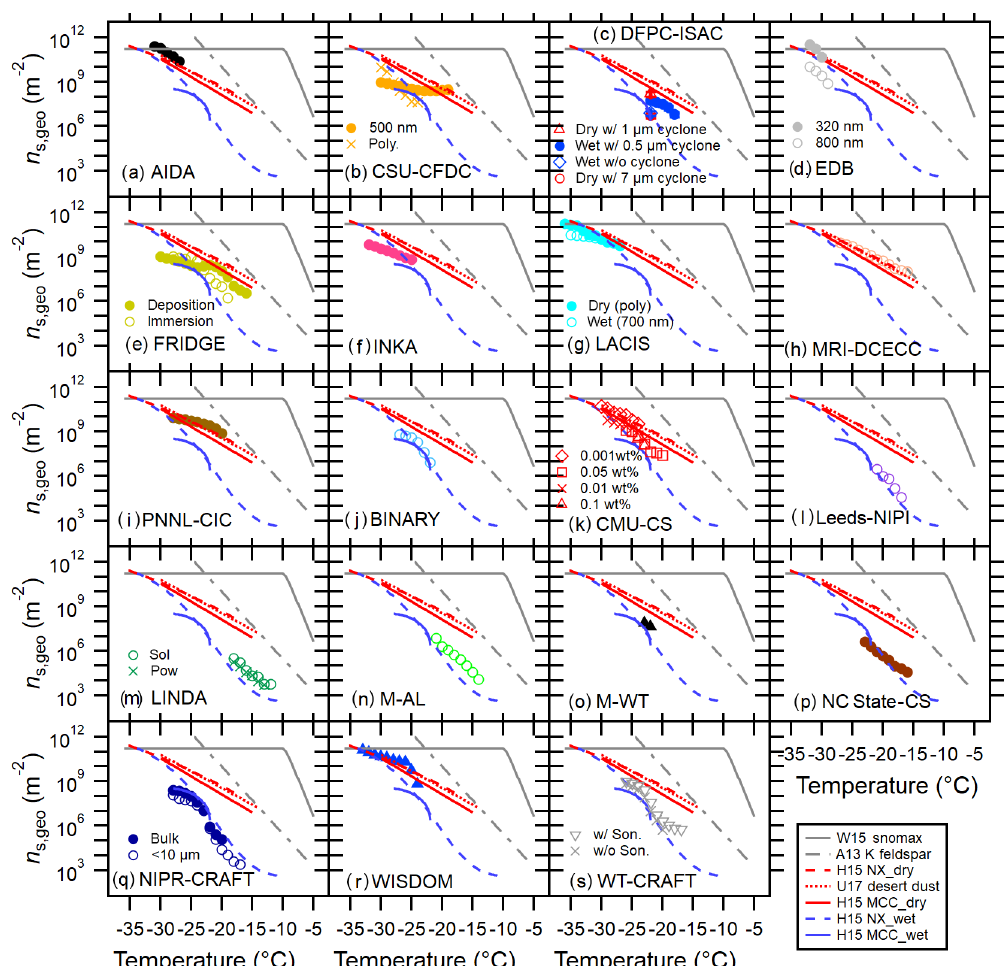
Figure 3. Intercomparison of 20 INP measurement methods for MCC using T -binned n s , geo . FRIDGE results of default (solid circles) and imm.mode (open circles) measurements are both presented in (e) . Reference immersion freezing n s (T ) spectra for MCC (H15a) illite NX (H15b), Snomax (Wex et al., 2015), desert dusts (U17; Ullrich et al., 2017) and K feldspar (A13; Atkinson et al., 2013) are also shown (see Sect. 3.2). Both aqueous suspension and dry dispersion results of FRIDGE are presented in panel e